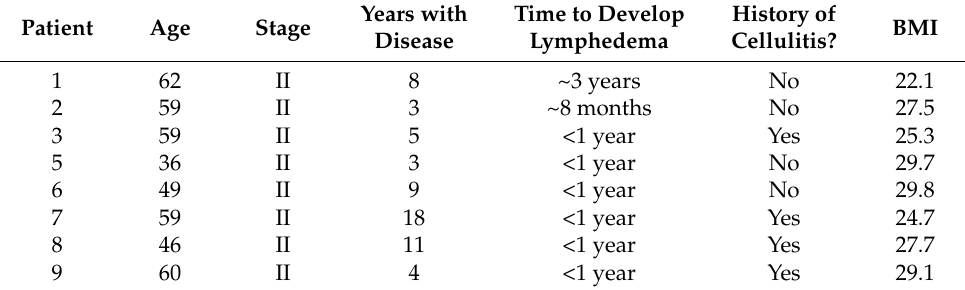
Table 4. Patient demographics.